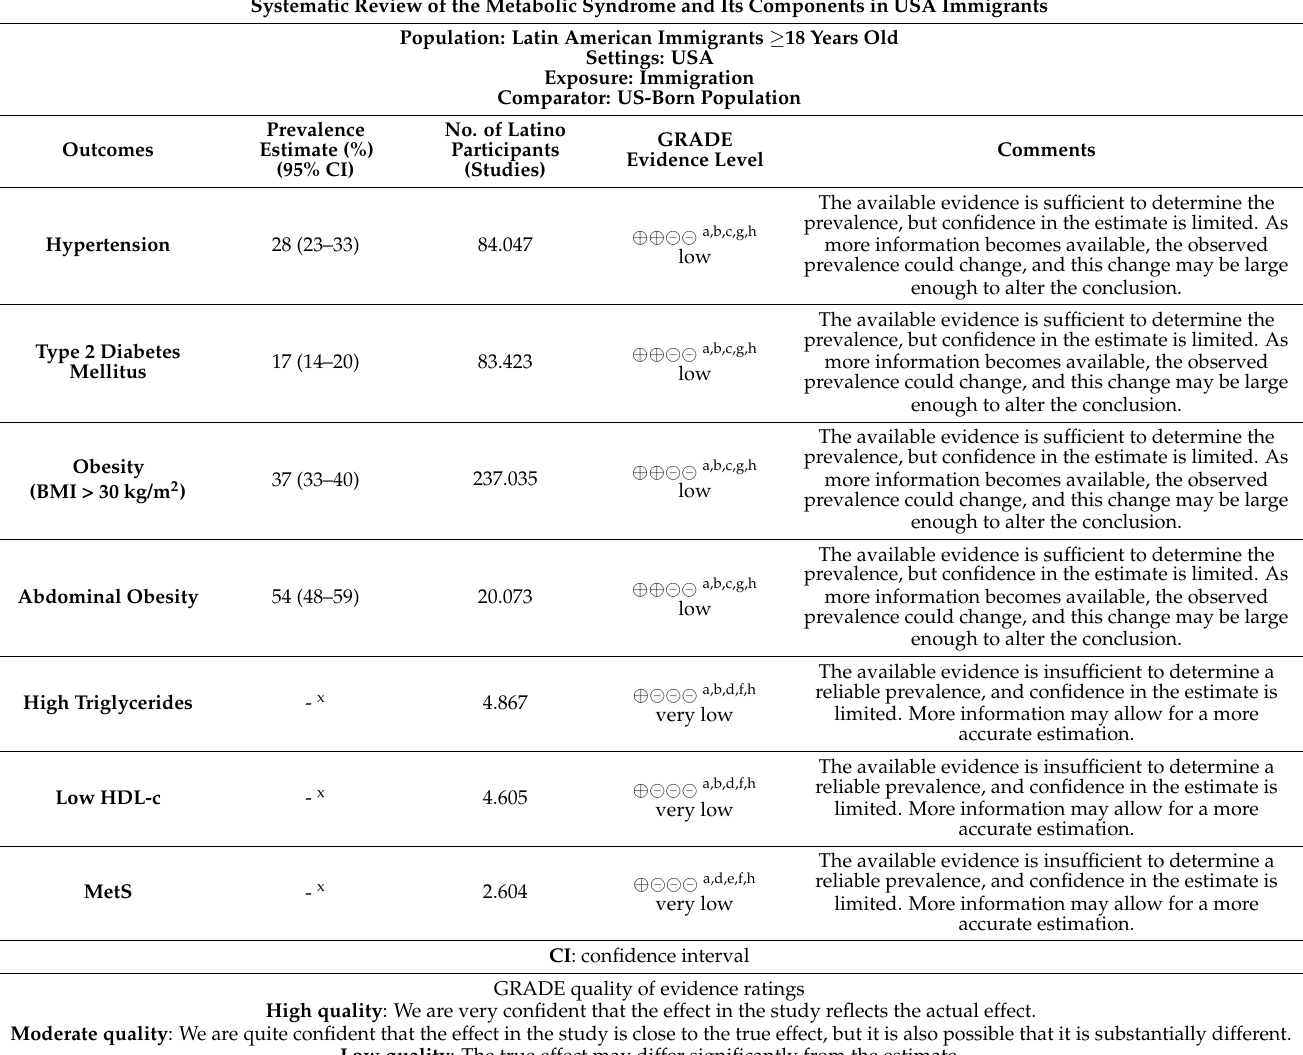
Table 7. Summary of